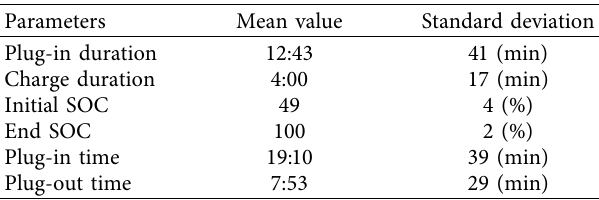
Figure 1: EV initial and end SOC for charge events in the Danish demo region of the green eMotion project. Table 2: Average SOC and charging time derived from the tes- t-en-EV project